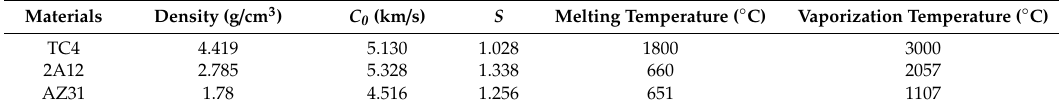
Table 1. Key impact parameters of various components for Ti / Al / Mg density-graded material.